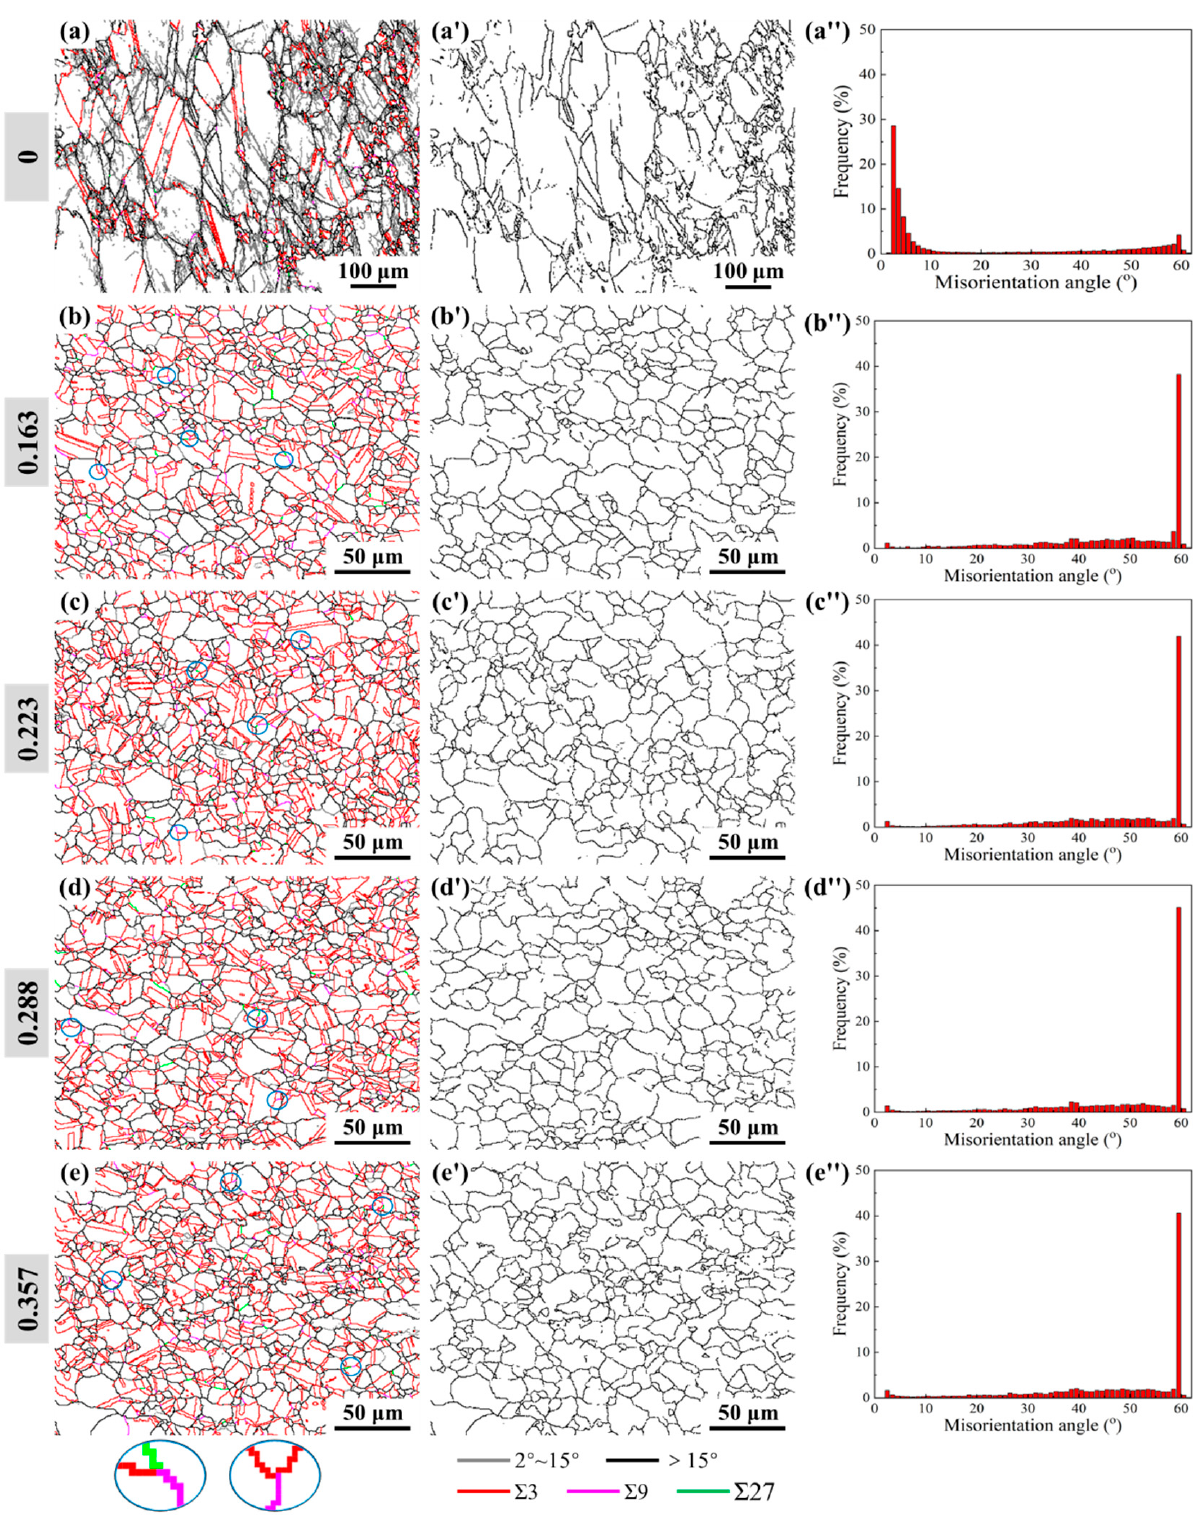
Figure 10. Microstructure characterization results after two-stage deformation with different prior cold strains and the same thermal deformation condition. ( a – e ) Band contrast maps with Σ 3 n twin boundaries; ( a ′ – e ′ ) random HAGBs connectivity maps; ( a ″ – e ″ ) distribution of misorientation angle. In order to quantitatively analyze the evolution of the Σ 3 n twin boundaries after two- stage deformation, the length fractions of the Σ 1 (LAGBs), Σ 3, Σ 9, and Σ 27 twin